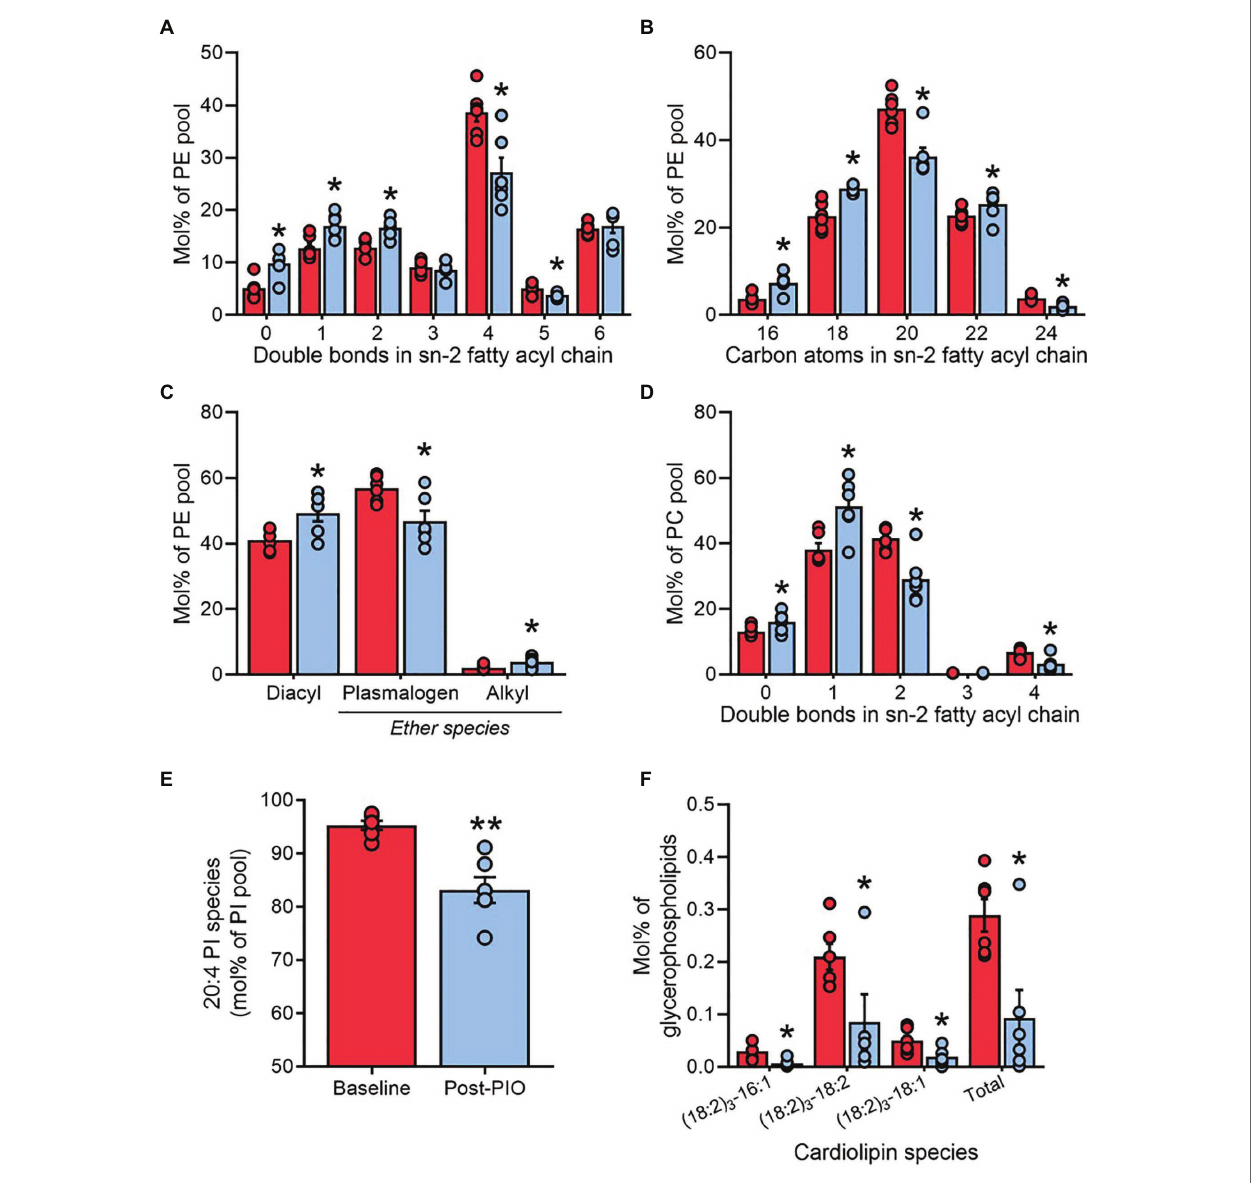
FIGURE 5 | Adipose tissue plasmenylethanolamines are lowered by pioglitazone treatment. Saturation number of double bonds; (A) and length number of carbon atoms; (B) of fatty acyl chains in the sn-2 position, and ether chain content (C) , of phosphatidylethanolamine (PE); Saturation of fatty acyl chains in the sn-2 position of phosphatidylcholine (D) ; arachidonic acid enrichment in phosphatidylethanolamine (E) ; content of cardiolipins (F) in paired adipose tissue samples at Baseline (red) and Post-PIO (blue). * p < 0.05, ** p < 0.01 vs. Baseline. Data are mean ± standard error (filled bars) and individual values (filled circles), normalized to the total molar content for each respective lipid class (A–E) , or to the total glycerophospholipid pool (F) , for n = 6